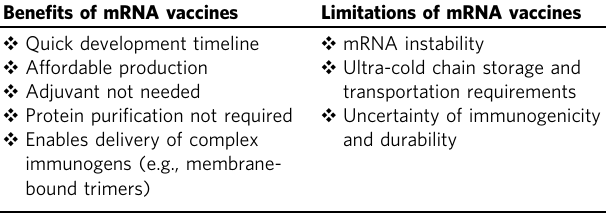
Table 1 Bene fi ts and limitations of HIV mRNA